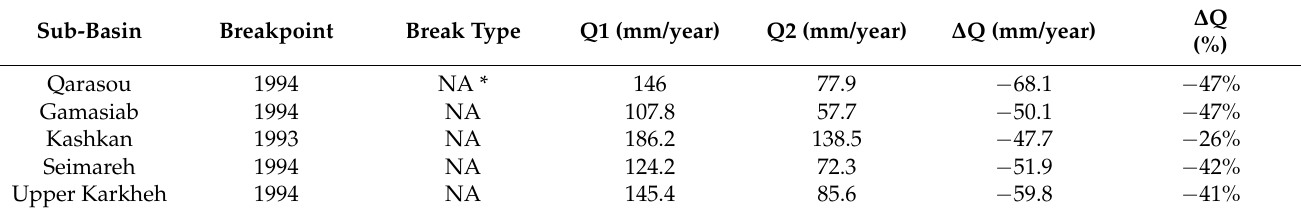
Table 2. Average streamflow variation for the pre-change period (Q1) to the post-change period (Q2), and type and magnitude of the change.